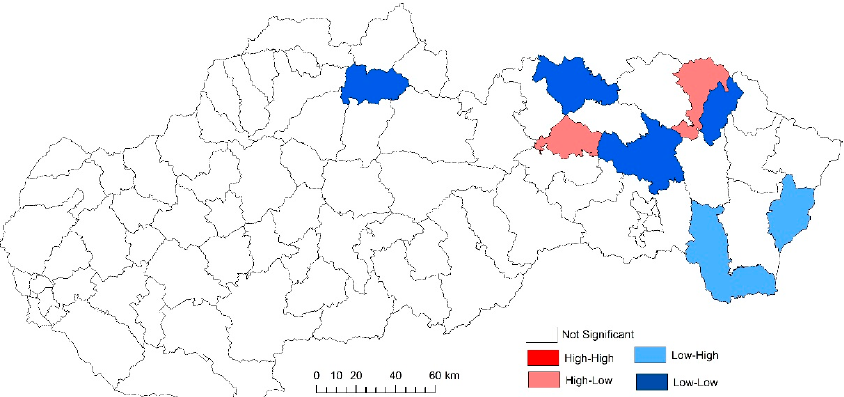
Figure 4. Reginalization of Slovakia based on the LISA analysis for standardized death rate of breast cancer per 1000 inhabitants of European Standard Population, 2007–2012. Source: Statistical Office of the Slovak Republic, 2019.